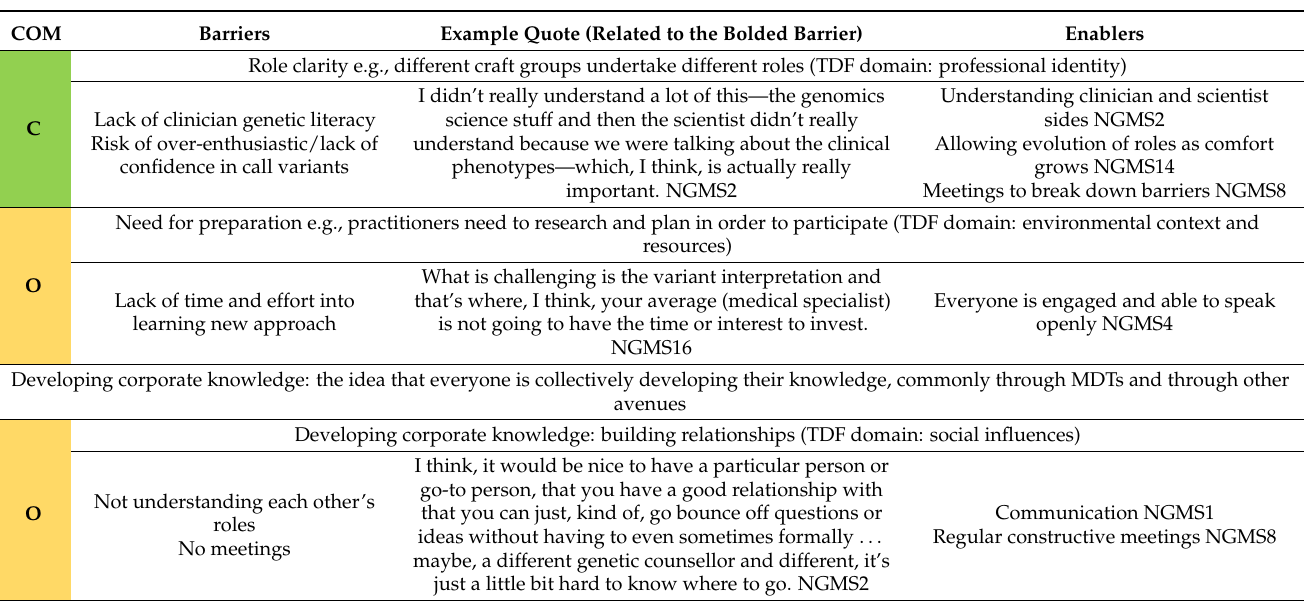
Table 3. Target behaviour area 2, (test selection and interpretation) grouped barriers coded by the Theoretical Domains Framework and Capability, Opportunity and Motivation Behaviour framework. Detailed information about the barriers and enablers reported for each grouped barrier can be found in the Supplementary Files (Supplementary Table